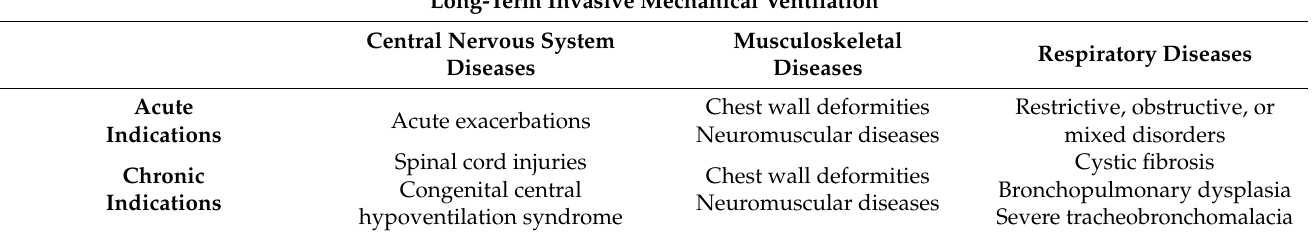
Table 4. Indications for long-term invasive mechanical ventilation initiation in children with medi- cal